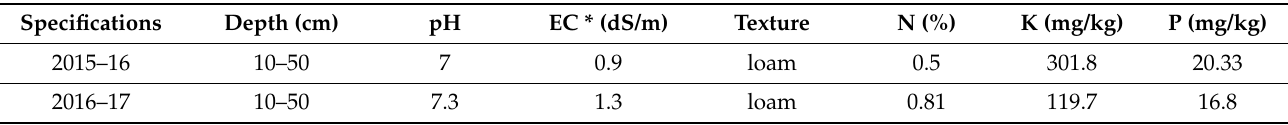
Table 1. The soil characteristics of experiment